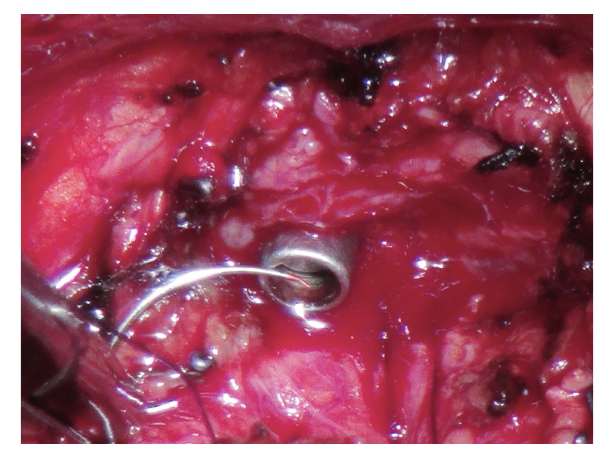
Antegrade nerve sparing of right lateral side figure 3 - continuous anastomosis (radical retropubic